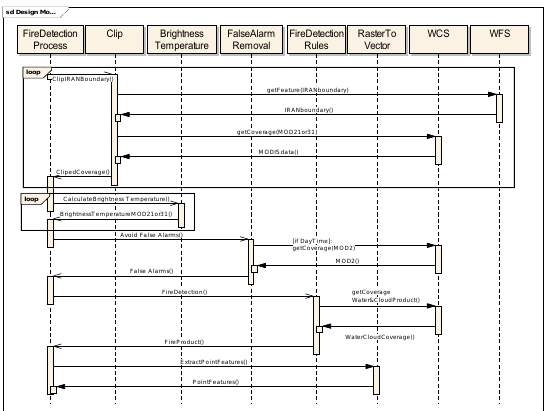
Figure 6. Workflow of services for fire